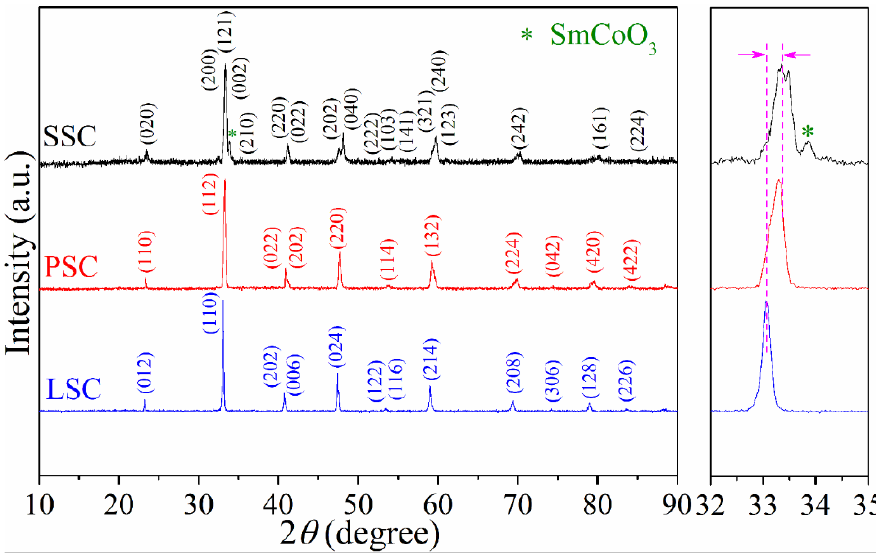
Figure 1. XRD patterns of the as-prepared LSC, PSC and SSC powders.